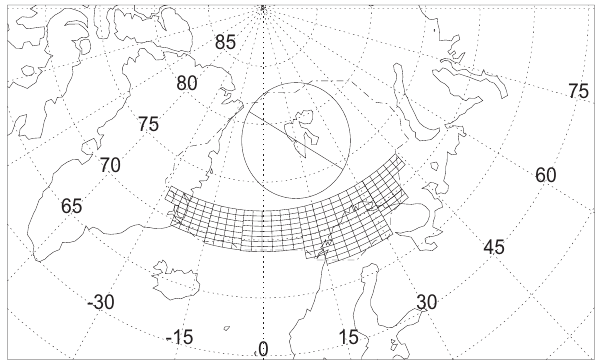
Fig. 6. An illustration of the observing geometry used in our model for the red sky event. The circle is the local horizon for Longyear- byen (78 ◦ N, 15 ◦ E) and the line through the circle indicates the azimuth of the Meridional Scanning Photometers. The dash-dot- dash outline that extends from Greenland to Novaya Zemlya and from northern Scandinavia and Finland to above Spitsbergen is the region of air, at potential temperature 550K, cold enough for the formation of ice PSC. The array of small rectangular boxes defines the location of the 243 southern PSC used in the model. The upper northern edge of the boxes corresponds to the sun’s shadow height at 25km altitude. Any PSC north of this boundary, at 25km alti- tude, cannot be directly illuminated by the